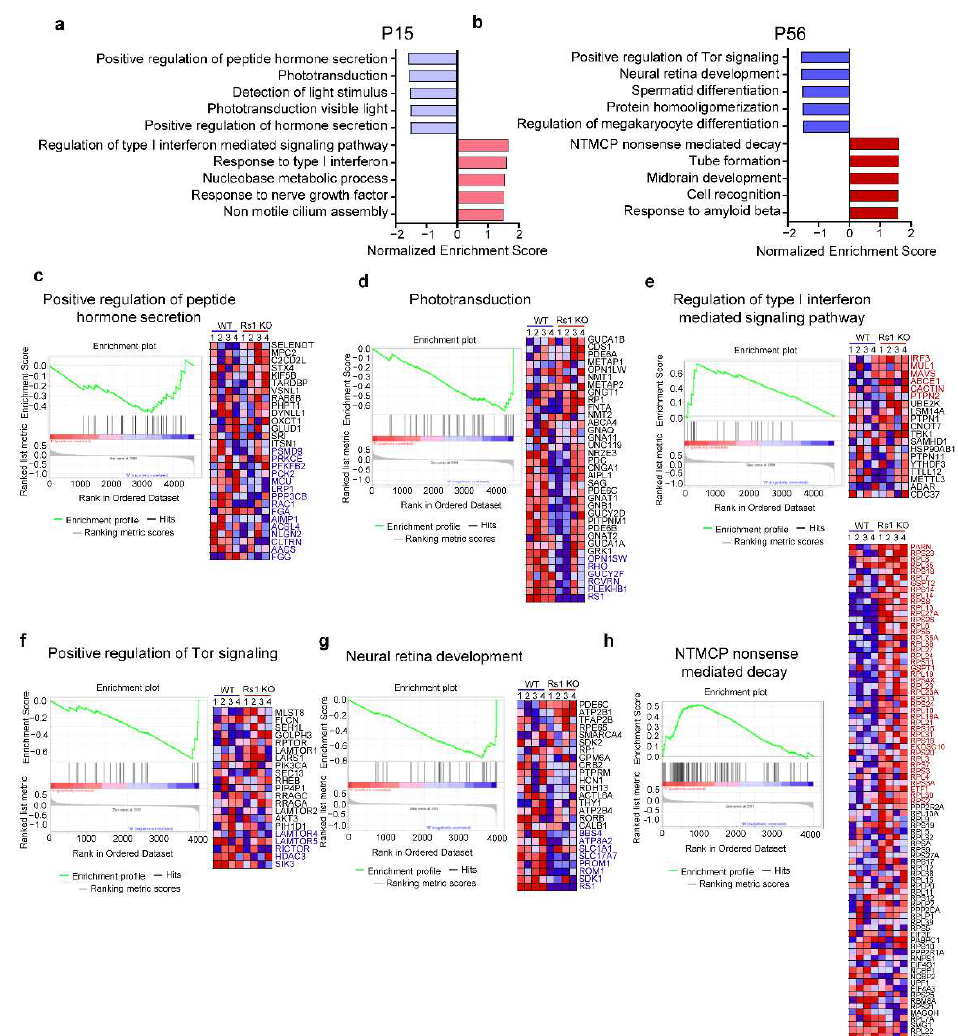
Figure 3. GSEA analysis of RS1-KO retinas. ( a , b ) Enriched gene sets of RS1-KO retinas at P15 ( a ) and P56 ( b ) using GSEA (version_4.1.0; database_c5.go.bp.v7.4.symbols.gmt). Top five upregulated (red) and downregulated (blue) gene sets are shown. ( c – e ). Enrichment plot (left) and heatmap (right) of the enriched gene sets at P15, including the positive regulation of peptide hormone secretion ( c ), phototransduction ( d ), and regulation of type I interferon-mediated signaling pathway ( e ). ( f – h ) Enrichment plot (left) and heatmap (right) of the enriched gene sets at P56, including the positive regulation of Tor signaling ( f ), neural retina development ( g ), and NTMCP nonsense-mediated decay ( h ). Proteins involved in the enriched gene sets are labeled on the right of the heat map, and core regulated proteins in specific gene sets are labeled with red (upregulated) or blue (downregulated) according to the direction of change. The enrichment score (ES) value calculation process is shown on the upper part of the enrichment plots. The particularly pronounced peak represents the ES value of the enriched gene set. Each line in the middle of the enrichment plots represents a gene in the gene sets and its ranked position in the gene list. Red represents positive correlation with phenotype (high expression), blue means negatively correlated with phenotype (low expression). GSEA, gene set enrichment analysis; NTMCP, nuclear transcribed mRNA catabolic process; ES, enrichment score.